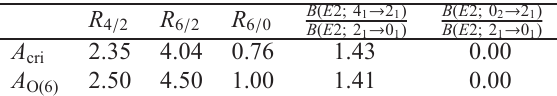
Table 1. The energy ratios R 4 / 2 = E 4 / E 0 R 6 / 0 = E 6 as well as the typical B ( E 2) ratios are shown for 1 2 N = 20, where A cri and A O(6) represent the quantities calculated from H cri and H O(6)